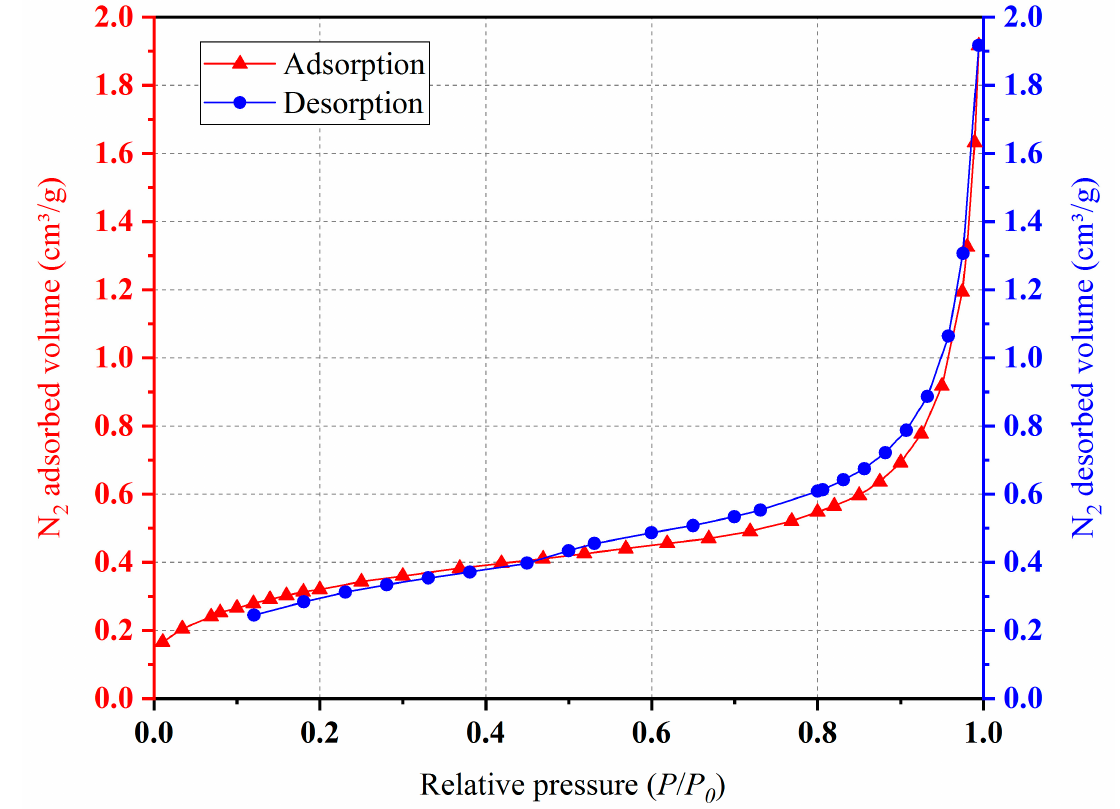
Figure 4. N 2 adsorption/desorption isotherms of ceramsite.